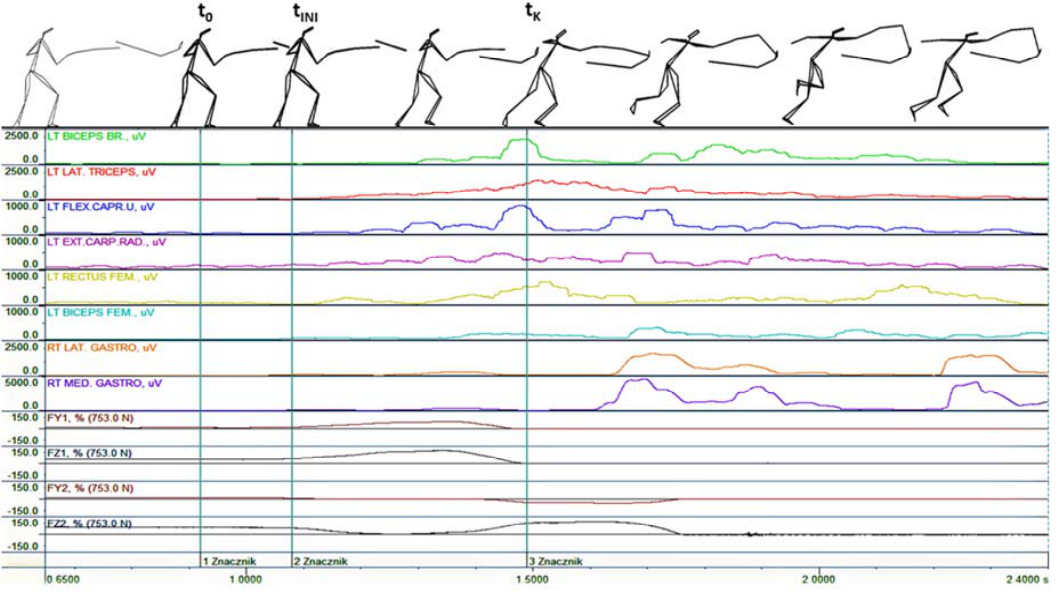
Figure 3. Bioelectric activity of selected muscles as well as the horizontal (FY1 and FY2) and vertical components (FZ1 and FZ2) of the ground reaction forces during a touch completed by a flèche in response to visual stimulation; 1—t 0 : Initiation of the move by the coach, 2—t INI : Fencer’s response, 3—t K : Instant corresponding to completion of the flèche. FY: horizontal component of ground reaction forces, FZ: vertical component of ground reaction forces.